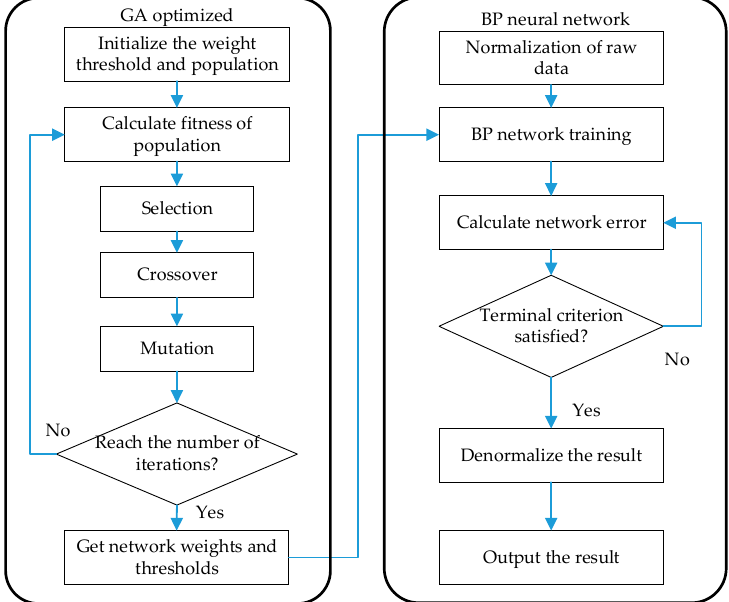
Figure 1. BP neural network optimized by the genetic algorithm